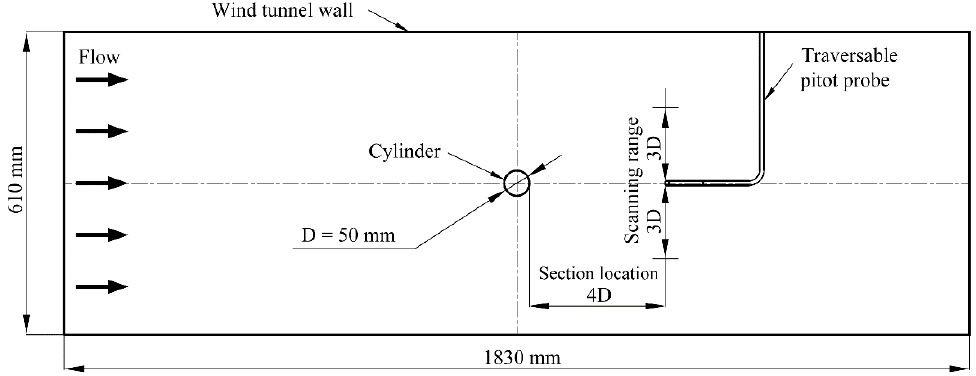
Figure 3. A schematic of the wake survey setup in the test section.